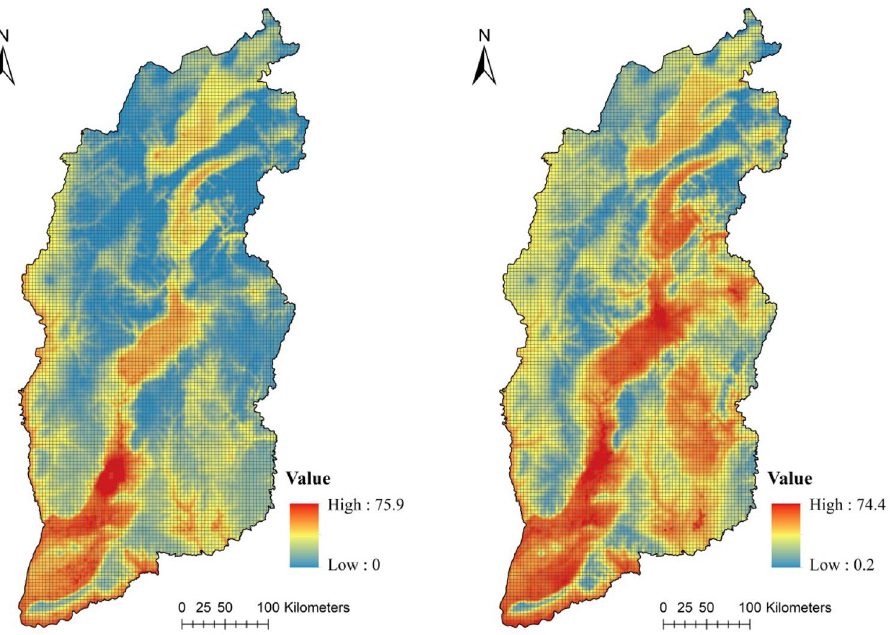
Figure 2. 3 × 3 km grid map and ACAG PM2.5 concentration data of Shanxi Province in 2000 and 2018 (units: μg/m 3